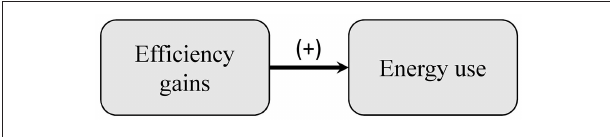
FIGURE 1 | Expected effect of efficiency gains on energy use (version 1). FIGURE 2 | Expected effect of efficiency gains on energy use (version